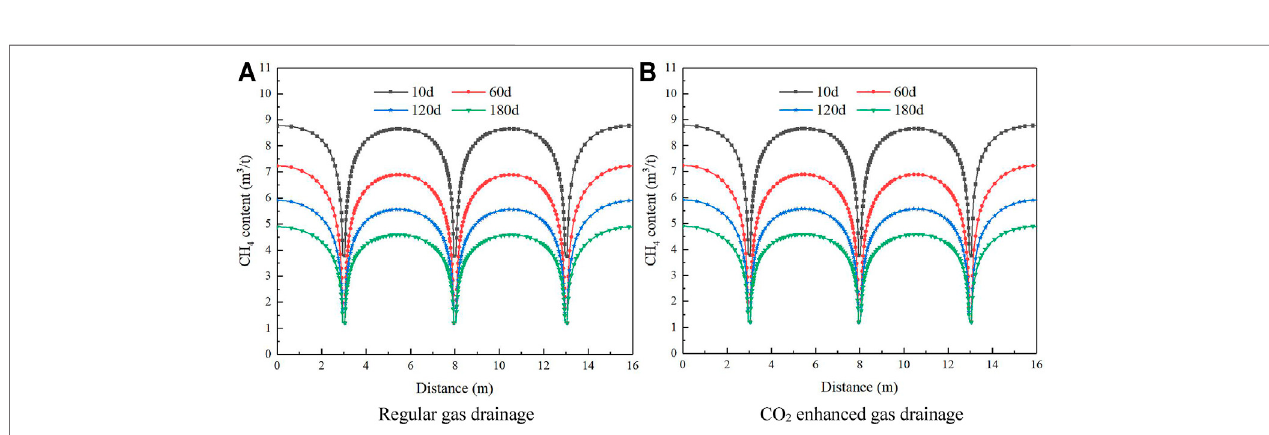
FIGURE5| EvolutionofCH 4 contentonthereferencelineABwithbothregularandCO 2 enhancedgasdrainage. (A) Regulargasdrainage. (B) CO 2 enhancedgas drainage.